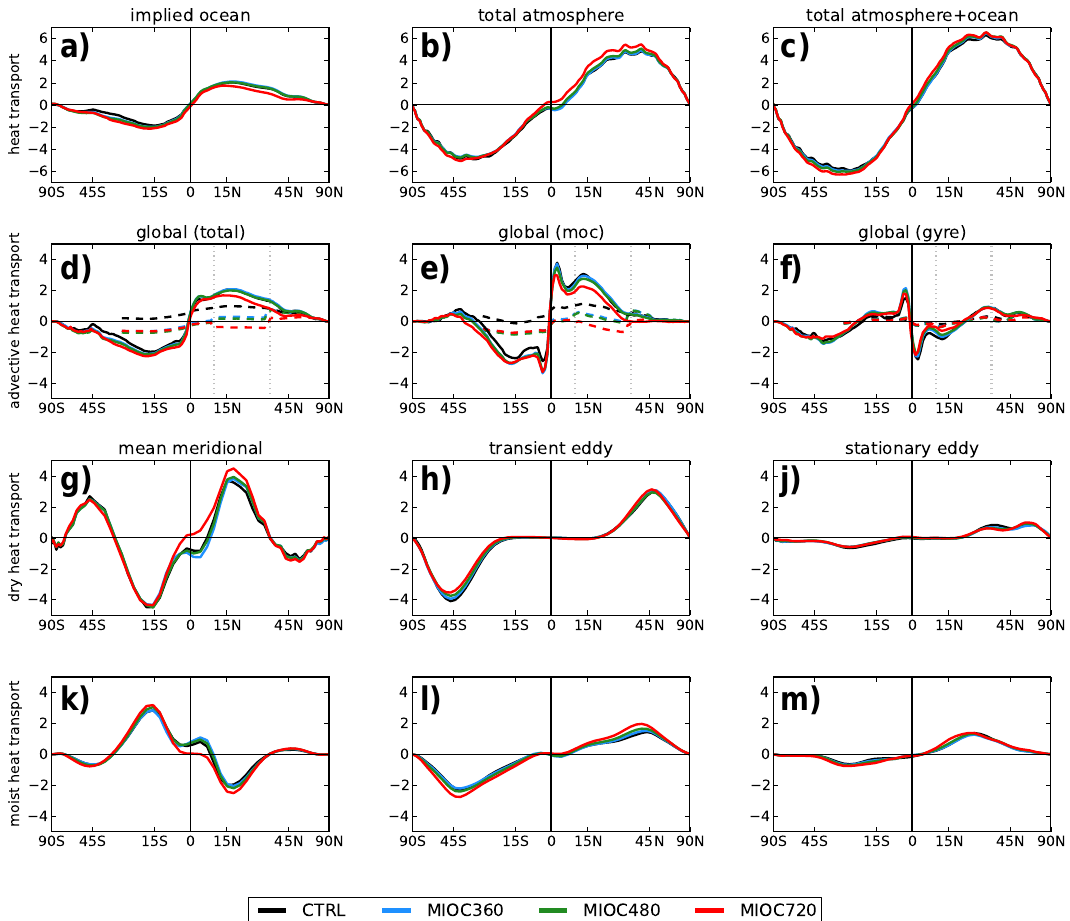
Fig. 9. Northward heat transport by (a) the global ocean, (b) atmosphere, and (c) ocean+atmsophere (in PW). The (implied) ocean heat transport in (a) is based on net surface energy budgets. (d) Total advective ocean heat transport according to Eq. (3) and the transports by (e) the MOC and (f) horizontal gyres. Here, dashed lines show the heat transport in the Atlantic Ocean. Atmospheric heat transport in (b) is calculated according to Eq. (2) and decomposed into (g,k) mean meridional, (h,l) transient eddy, and (j,m) stationary eddy